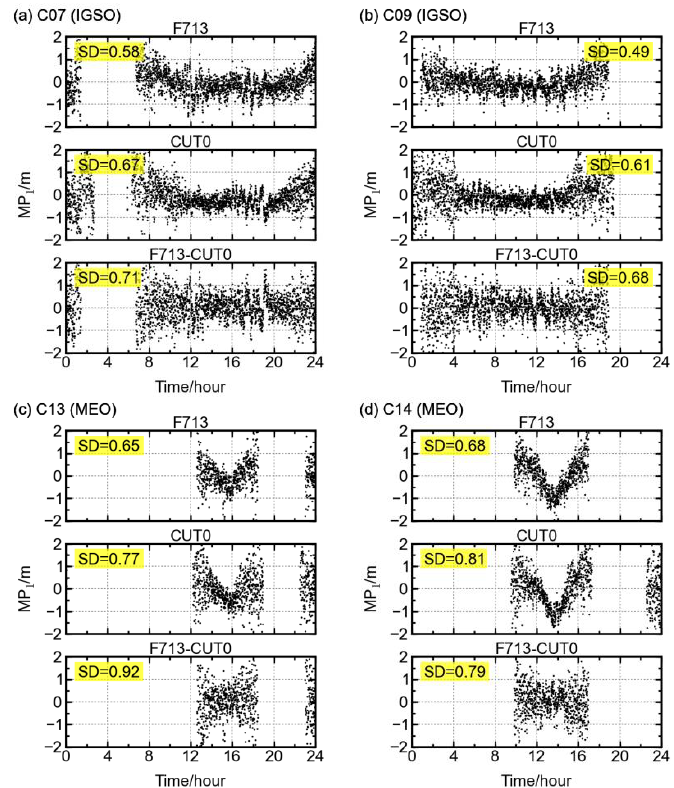
Figure 8. The systematic bias in multipath combination is eliminated through a between-station differencing. The single-station elevation-angle dependent troughs for satellites ( a ) C07, ( b ) C09, ( c ) C13, and ( d ) C14 vanish after the between-station differencing is performed.